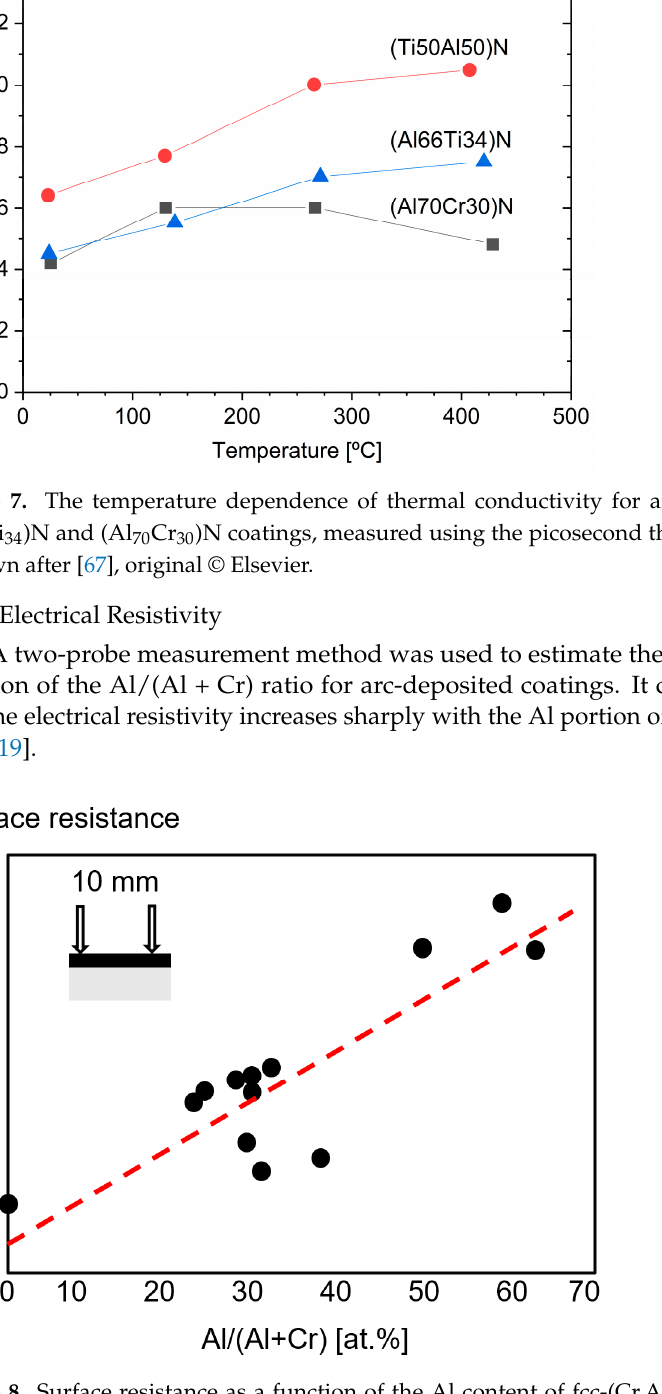
Figure 8. Surface resistance as a function of the Al content of fcc-(Cr,Al)N and fcc-(Al,Cr)N arc- deposited coatings, redrawn after [19], original ©